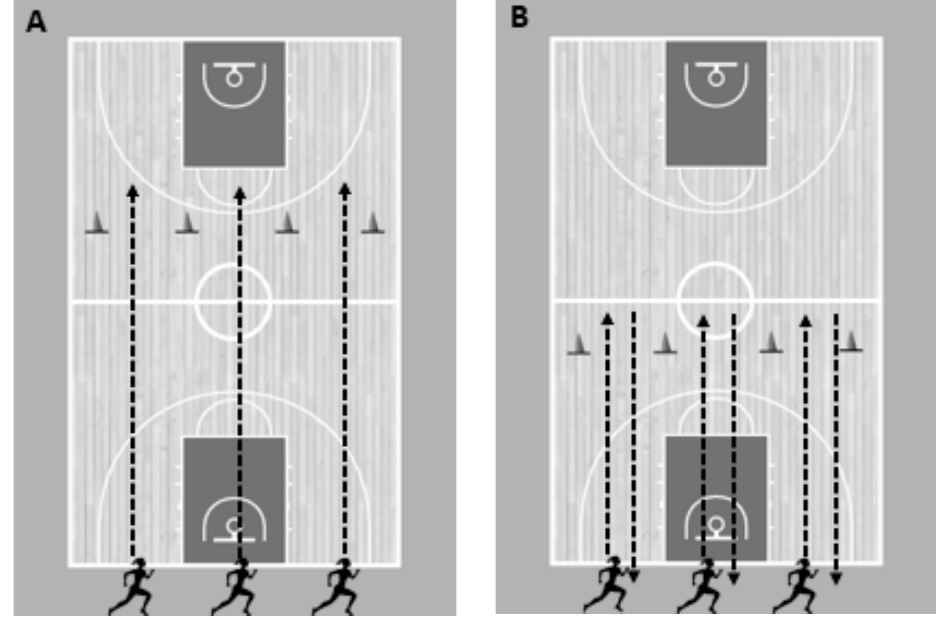
Figure 1. Examples of different experimental setups. ( A ) NCOD group and ( B ) COD group.